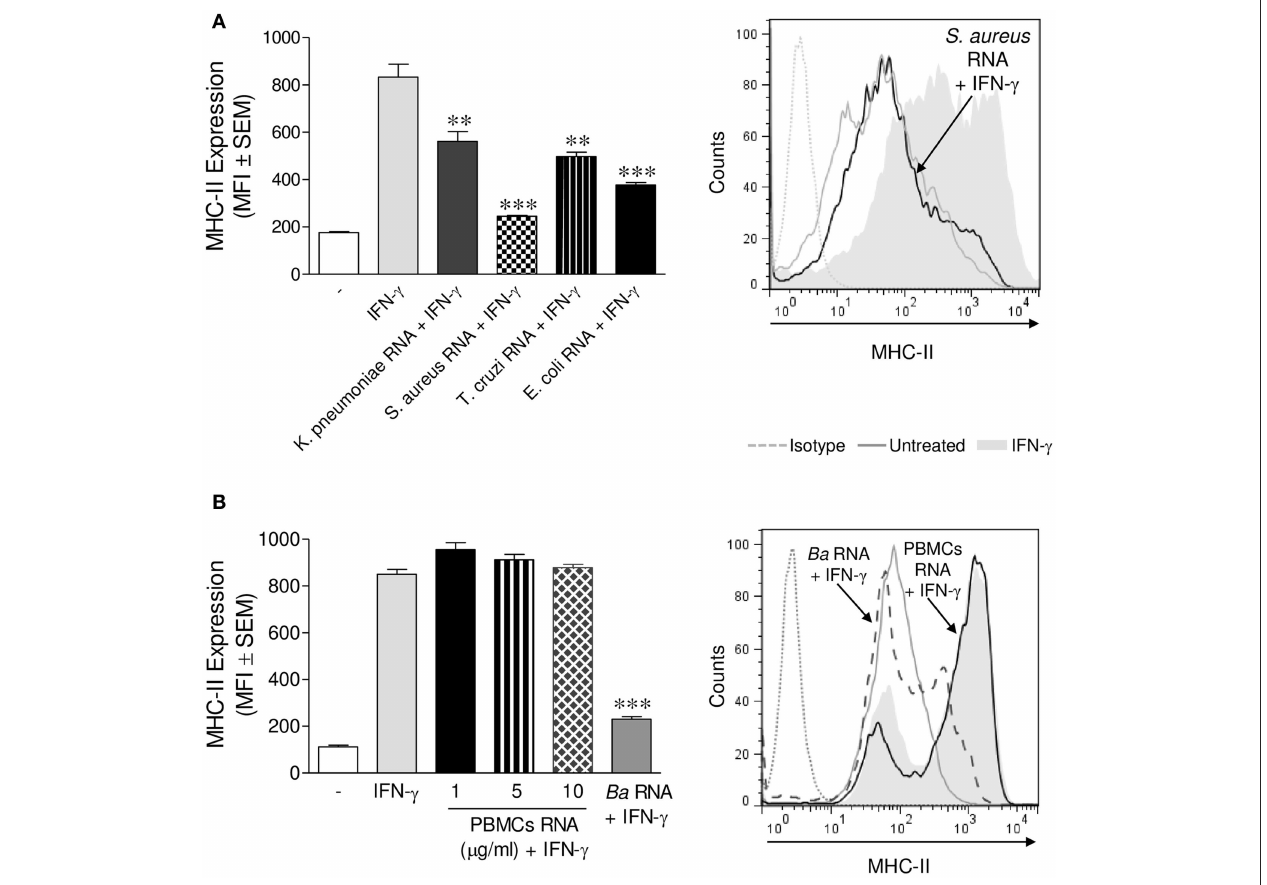
FIGURE 3 | MHC-II down-modulation could be extended to RNAs from different microorganisms. (A) THP-1 cells were treated with RNAs from K. pneumoniae , S. aureus , E. coli, and T. cruzi (10 µ g/ml) in the presence of IFN- γ for 48h. (B) THP-1 cells were treated with different doses of PBMCs RNA in the presence of IFN- γ for 48h. B. abortus RNA (10 µ g/ml)-treated cells were used as a control. MHC-II expression was assessed by flow cytometry. Bars represent the arithmetic means ± SEM of five independent experiments. MFI, mean fluorescence intensity. ** P < 0.01 ; *** P < 0.001 vs. IFN- γ -treated